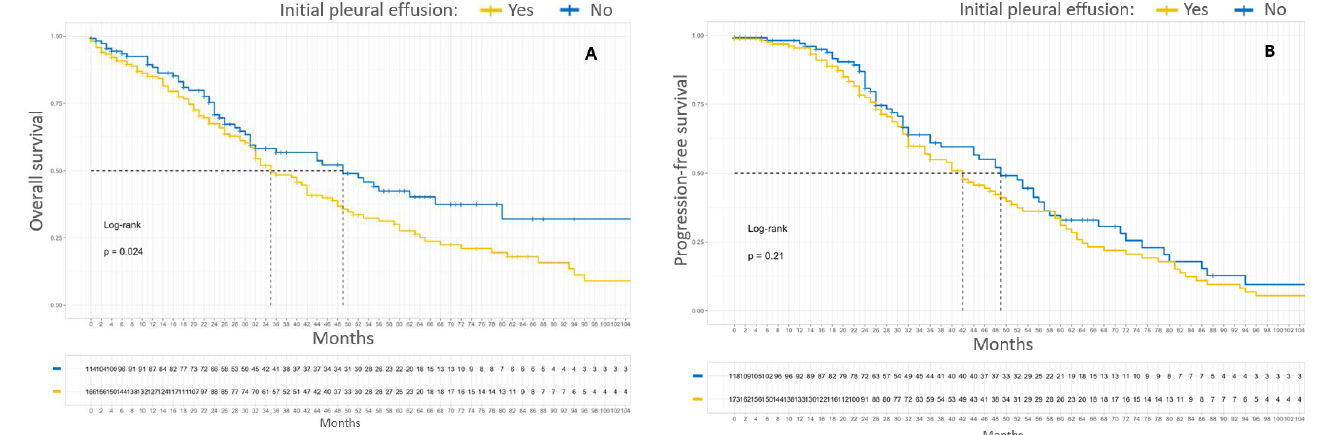
Figure 3. Kaplan – Meier OS ( A ) and PFS ( B ) curves for patients with FIGO stage IV EOC according to initial pleural effusion. In yellow, patients with pleural initial effusion. In blue, patients without initial pleural effusion.